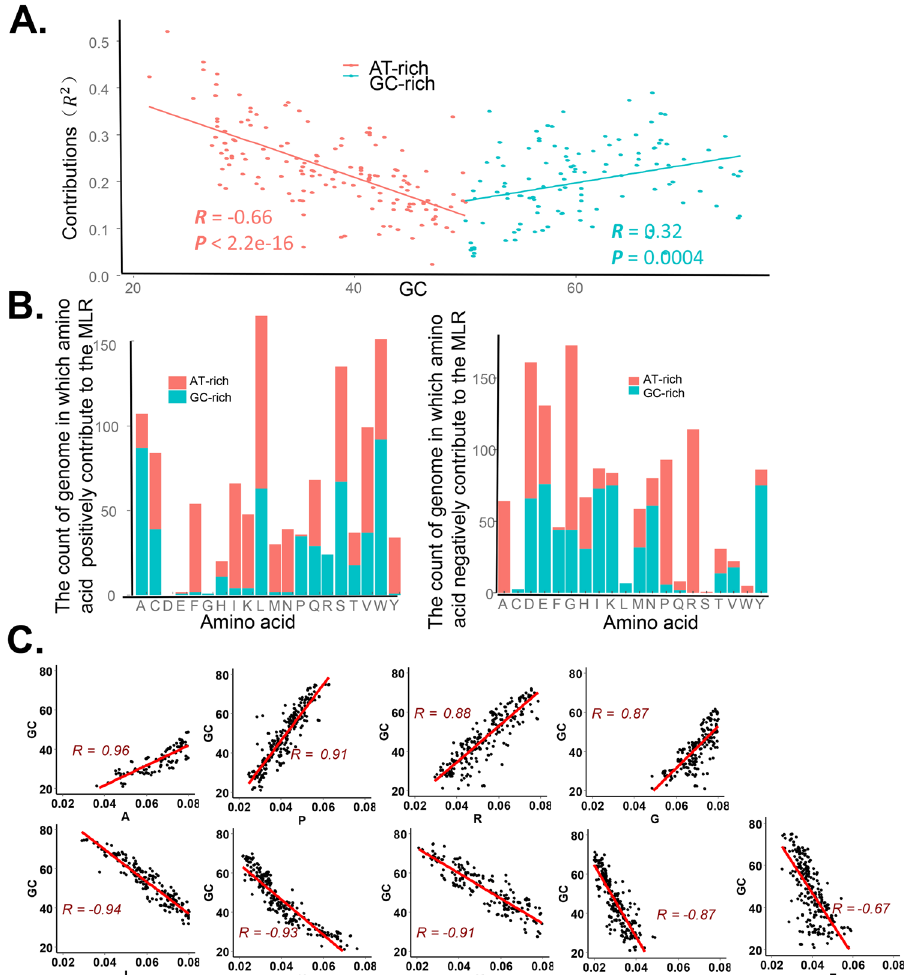
Figure 2. GC content influences the contributions of amino acid compositions to the evolutionary rates in GC-rich organisms and AT-rich organisms. ( A ) The relationship between GC content and the contributions of amino acid compositions to evolutionary rates for MLRs. ( B ) The count of the genomes that amino acid compositions negatively/positively contribute to the MLR in GC-rich and AT-rich organisms. The 20 amino acid types are represented by the letters A, C, D, E, F, G, H, I, K, L, M, N, P, Q, R, S, T, V, W and Y. ( C ) The point plots between amino acid compositions and GC contents. For GC-rich/AT-rich amino acids, the average compositions of these amino acids of 273 organisms are positively/negatively correlated with the GC content ( P ≪